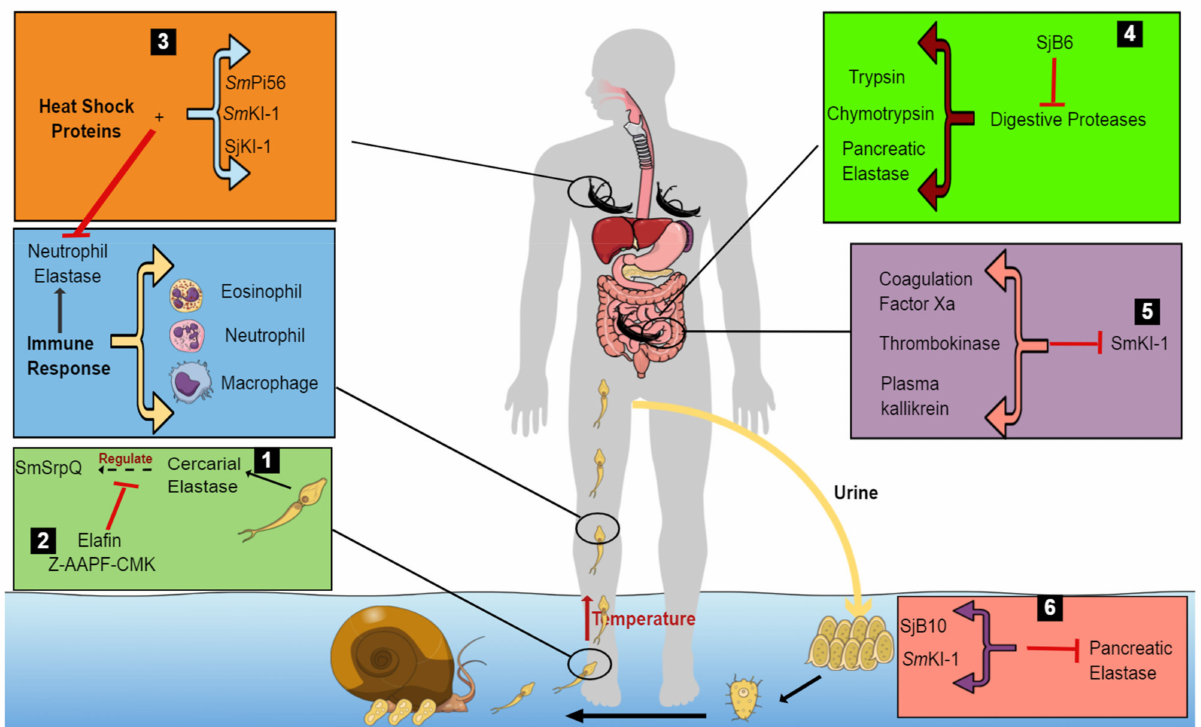
Figure 1. Model proposing the survival mechanisms of schistosomes within the host by protease inhibitors. The cercariae penetrate the human skin using cercarial elastase, which secretes a protease inhibitor, SmSrpQ. This regulates the production of cercarial elastase, in this way protecting the cercariae from its own elastase (1). The presence of CE inhibitors, Elafin and Z-AAPF-CMK, inactivates CE, blocking SmSrpQ regulation, and thus, preventing successful host penetration (2). However, in their absence, the cercariae migrate through various tissues in the host. This stimulates an immune response in the human host, leading to the release of effector cells and specific proteases such as NE to defend the human body (2). To counteract the host’s immune response, schistosomules secrete various protease inhibitors (SmPi56, SmkI-1 and SjKI-1) and heat shock proteins to inhibit the effects of NE (3). In the small intestine (4), schistosomes escape digestion by digestive enzymes through the secretion of SjB6, which inhibits digestive proteases within the host (trypsin, chymotrypsin and pancreatic elastase). In the mesenteric veins of the host, adult worms prevent blood coagulation by secreting SmKI-1, which inhibits various blood-clotting factors, in this way interfering with blood flow to vital organs of the body (5). The worms survive and produce eggs to continue the infection cycle. These eggs are protected from the effects of pancreatic elastase by SjB10 and SmKI-1